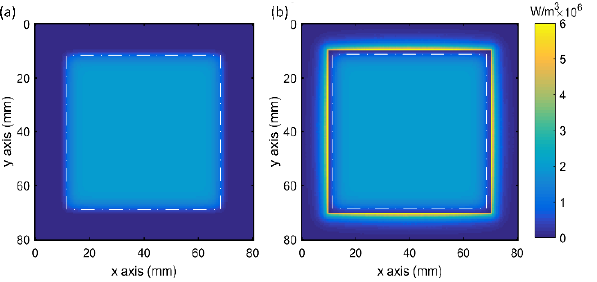
Figure 4. Heat density distribution in the gain slab ( a ) without and ( b ) with the absorbing cladding layer, and the laser beam area is indicated in the dashed frame on the drawing.